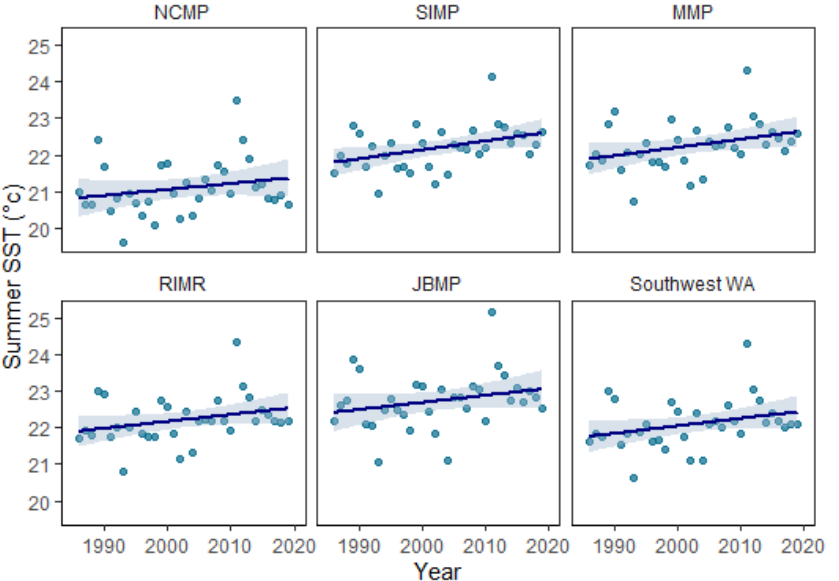
Figure 3. Long-term increase in summer sea-surface temperature (SST) for Ngari Capes Marine Park (NCMP), Shoalwater Islands Marine Park (SIMP), Marmion Marine Park (MMP), Rottnest Island Marine Reserve (RIMR), Jurien Bay Marine Park (JBMP), and all five south-west WA marine parks based on mean summer (March) SST from 1986–2019 (black trend line, dashed red indicates 95% confidence interval; see Table 1 for trend line values). Data source: NOAA Coral ReefWatch 5km SST (NOAA, 2021). Table 1. The coordinates (latitude and longitude), mean annual sea surface temperature (SST) between 1986 and 2019, the long-term increase in SST based on monthly mean summer (March) temperature, and the maximum degree heating weeks (DHW).